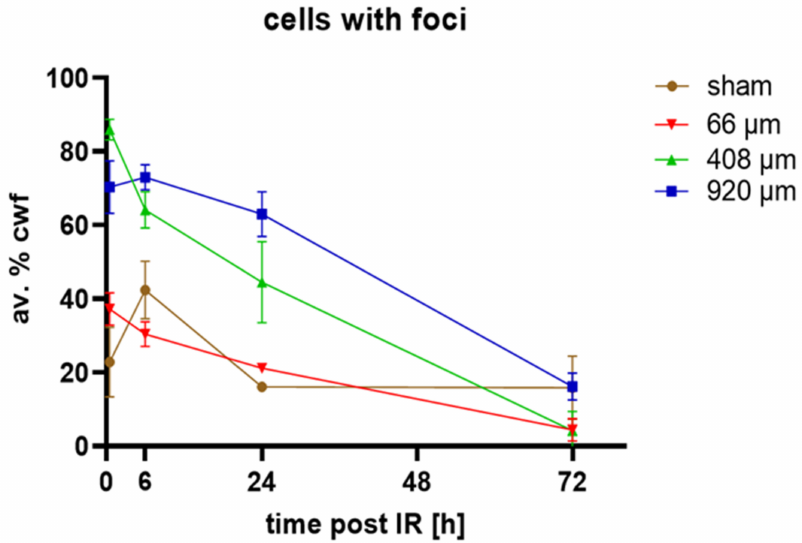
Figure 5. Average percentages of cells with DSB foci (av.% cwf; 53BP1 and/or γ -H2AX foci). Sham- irradiated (brown line) epidermis models showed ~20% cells with foci 0.5, 24 and 72 h post-irradiation, while at 6 h there were 40% cwf. Wide-field (920 µ m, blue line), 408 µ m (green line) and 66 µ m pBMRT induced a significantly increased percentage of cells with foci relative to sham at 0.5 h post-IR. Minibeams of 920 and 408 µ m induced significantly increased frequencies of cells with foci 6 h and 24 h after IR. The frequencies of damaged cells were similar to sham at 72 h post-IR. All average values at 72 h represent 53BP1 foci only as there was a large cytoplasmic background for γ -H2AX signals. Each data point represents the average ± SD of n = 9 sections of 3 models for each condition, except for 24 h sham ( n = 6) and irradiated models at 72 h ( n =